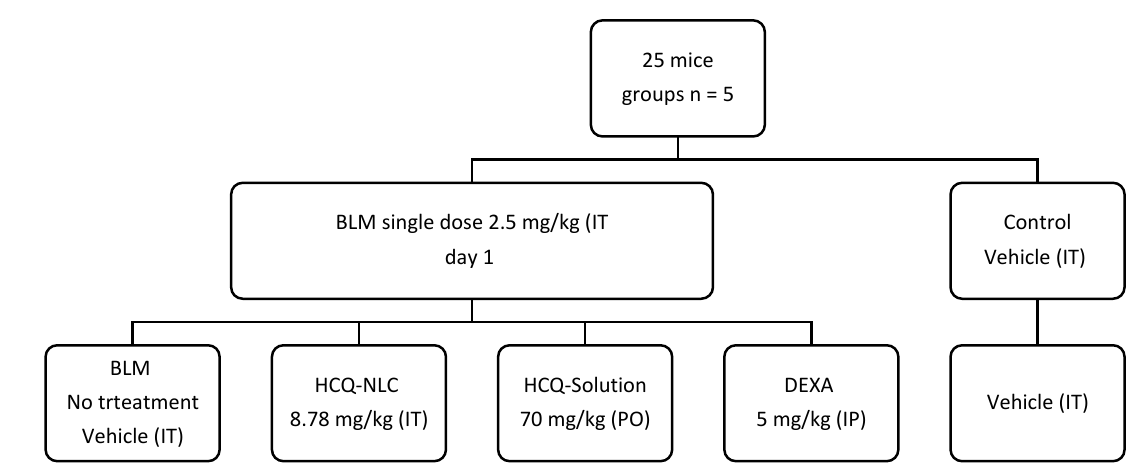
Figure 1. Animal experiment